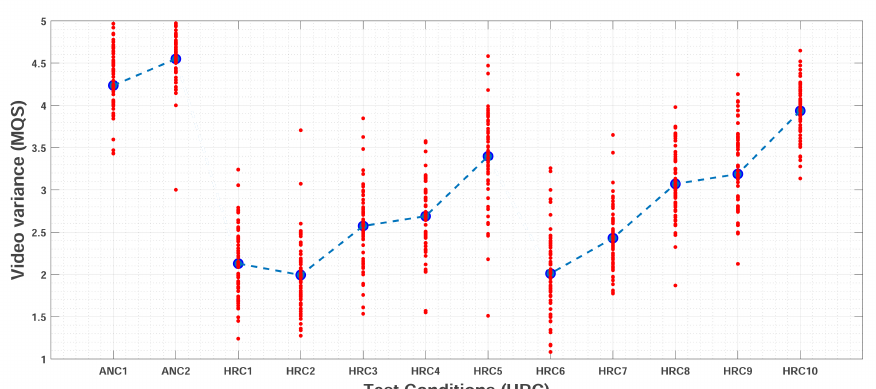
Figure 5. Mean Quality Score (MQS), and its respective spread of scores, for the different Hypothetical Reference Circuit (HRC) in Experiment 1.